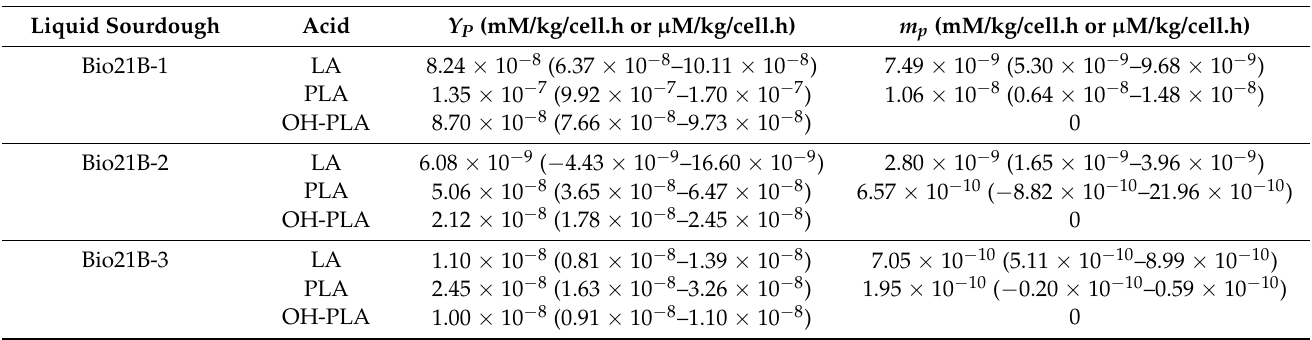
Table 4. Estimated kinetic parameters Y p (mM/kg/cell.h or µ M/kg/cell.h) and m p (mM/kg/cell.h or µ M/kg/cell.h) relevant to lactic, phenyllactic (PLA), and hydroxy-phenyllactic (OH-PLA) acid production by L. plantarum ITM21B in the Bio21B